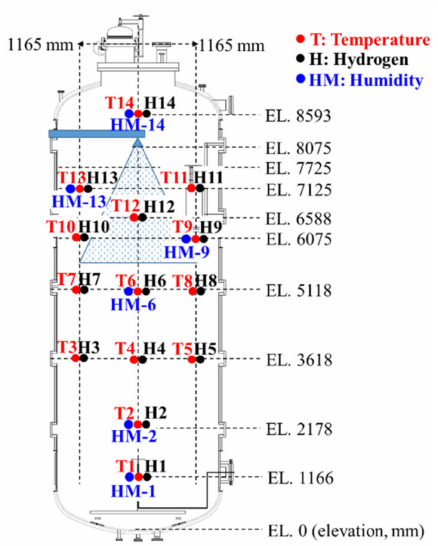
Figure 2. Arrangement of gas temperature, hydrogen, and humidity sensors for SPARC spray test